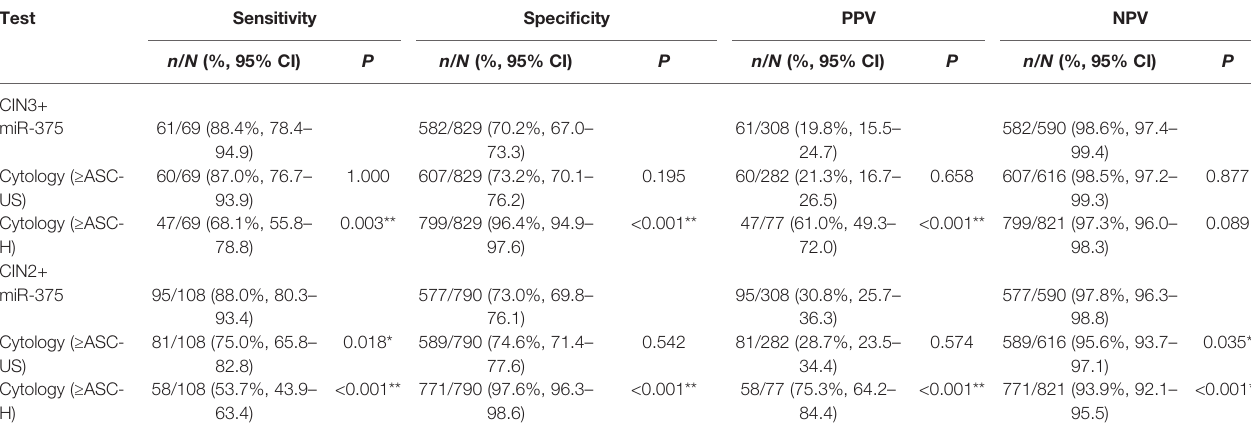
TABLE 1 | Comparison of performance ef fi ciency among miR-375 detection and cytology tests for identifying CIN3+ and CIN2+ in HPV-positive